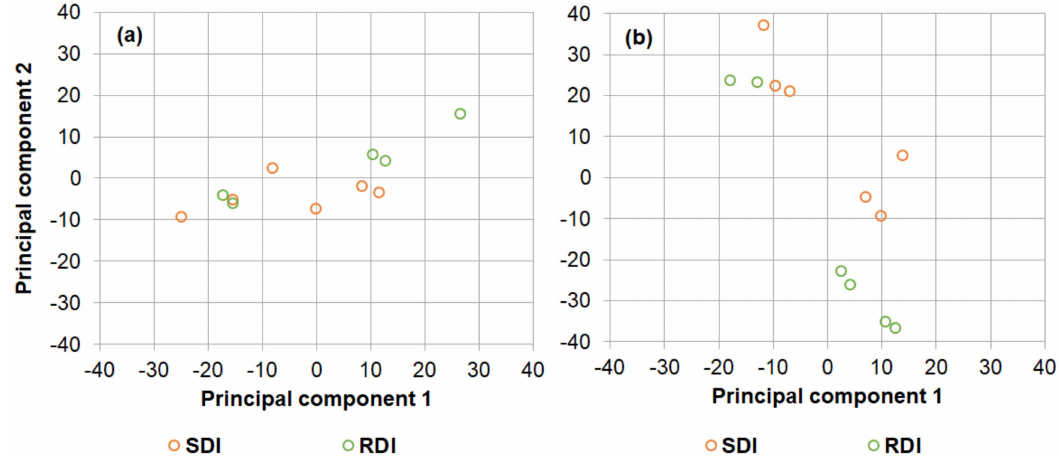
Figure A1. Principal component analysis scores for 11 trees in 2019 ( a ) and 12 trees in 2021 ( b ) with soil water content